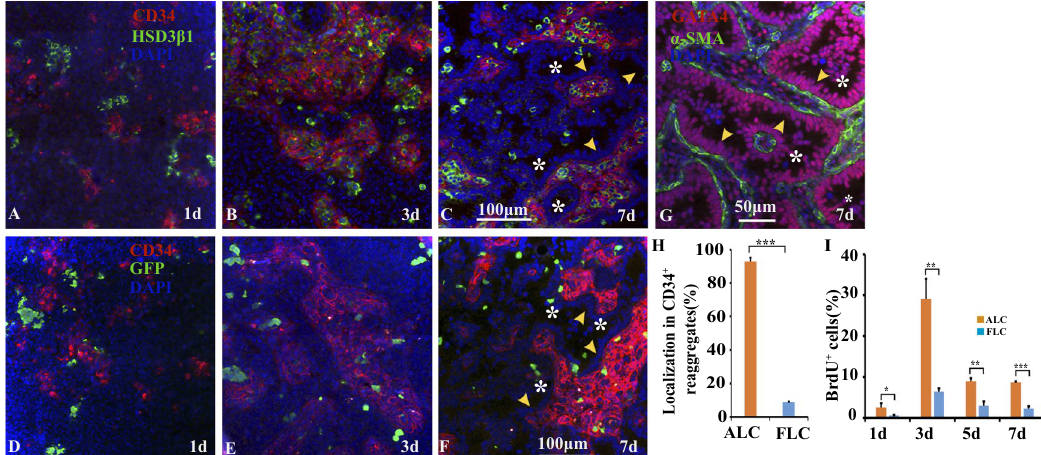
Figure 1. FLCs and ALCs showed different properties in re-aggregate culture of testicular cells. ( A – F ) Immunofluorescence of CD34, HSD3β1 ( A – C )/GFP ( D – F ) and DAPI on day 1 ( A , D ), day 3 ( B , E ) and day 7 ( C , F ). ( G ) shows immunofluorescence of GATA4 (a marker of SCs and LCs), α-SMA and DAPI on day 7. Arrowheads and * show a single layer of SCs and lumen, respectively, in seminiferous tubules formed on day 7. Negative controls for the antibodies used in ( A - G ) were shown in Supplementary Fig. S1. ( H ) Percentages of ALCs and FLCs which were localized within CD34 + cell-aggregates among all the ALCs and FLCs, respectively, in sections on day 7 were shown. The former was obtained as described in Supplementary Methods. Total numbers of HSD3β1-positive cells and GFP-positive cells counted was 1916 and 538, respectively, in 3 experiments. ( I ) Proliferative activity of ALCs and FLCs during culture. The percentage of BrdU + ALCs was obtained as described in Supplementary Methods. Total numbers of HSD3β1-positive cells counted for each day in 3 experiments were 1492 (1d), 2107 (3d), 1507 (5d), and 1774 (7d), while those of GFP-positive cells counted were 534 (1d), 620 (3d), 527 (5d), and 671 (7d). Student’s t -test was performed for comparison between ALCs and FLCs in ( H ) and ( I ). *** < 0.001, ** < 0.01, * <